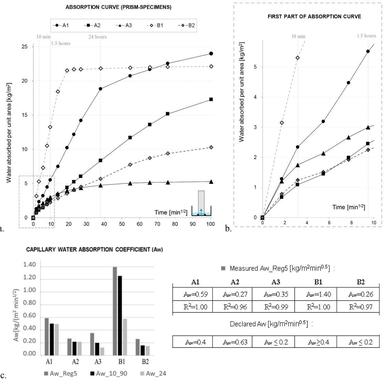
Capillary absorption curves of single materials (prism specimens).